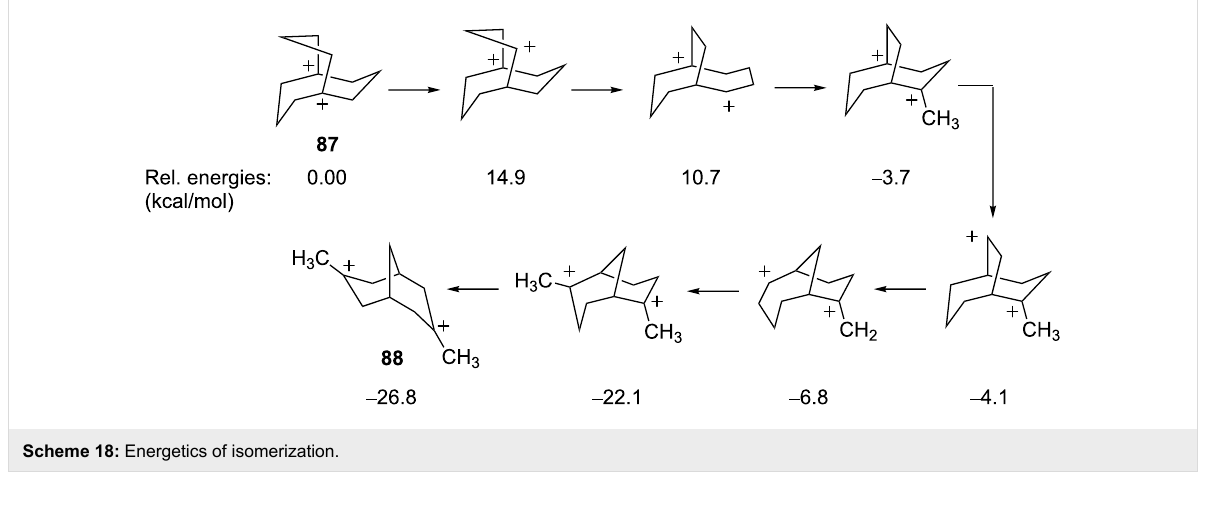
Scheme 18: Energetics of isomerization.